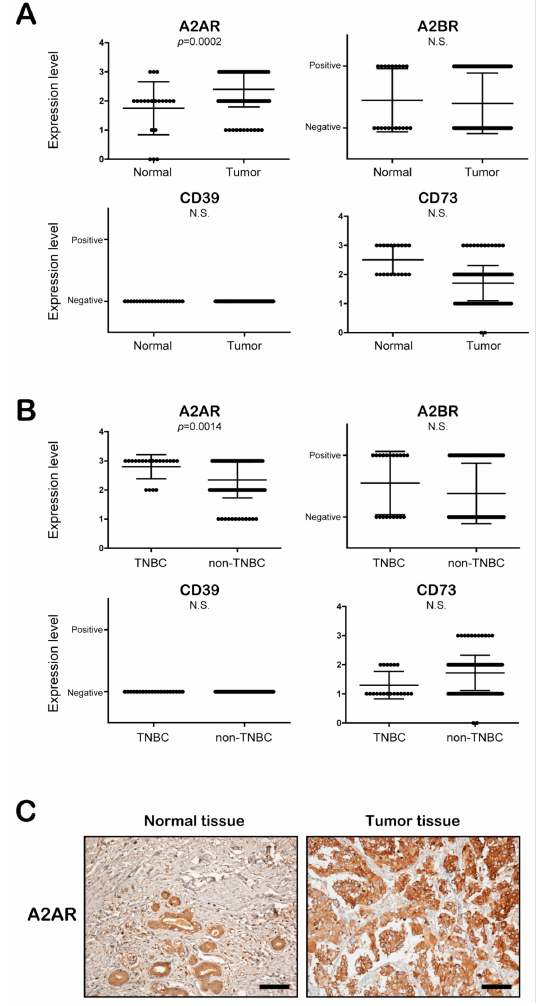
Figure 3. A2AR expression is significantly increased in the tumor tissue, especially in TNBC, com- pared to normal epithelial tissues of breast cancer patients. ( A , B ) The expression levels of A2AR, A2BR, CD39, and CD73 were evaluated in normal epithelial tissues ( n = 20) and tumor tissues ( n = 180) ( A ) and in TNBC tissues ( n = 20) and non-TNBC tissues ( n = 160) ( B ) of patients with breast cancer. ( C ) Immunohistochemical staining of A2A2R in tumor tissues and normal epithelial tissues of breast cancer patients (scale bar, 100 µ